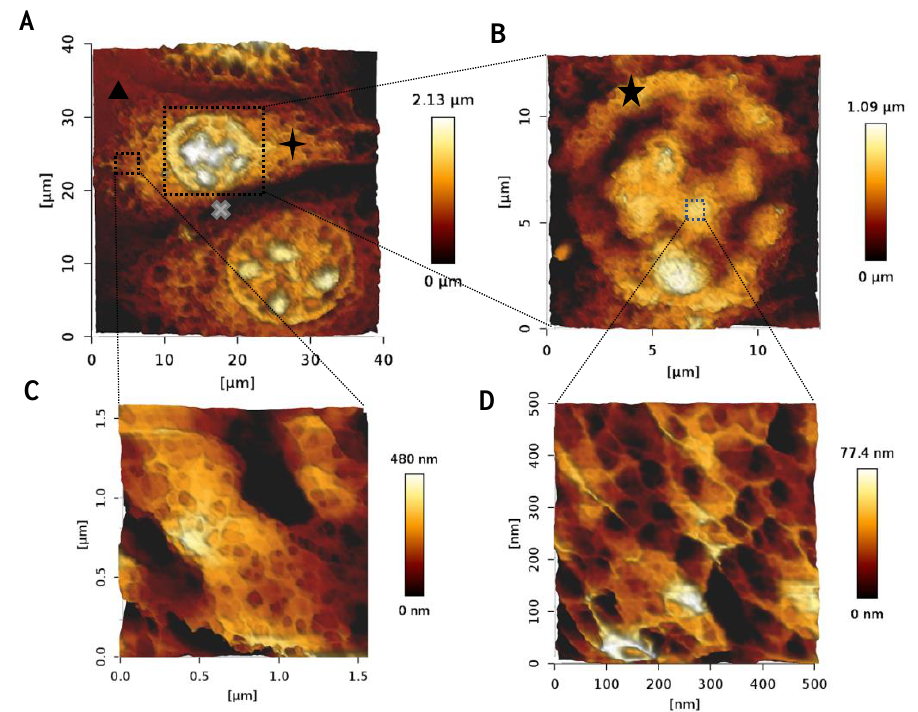
Figure 5. AFM 3D images taken in PBS of ( A ) a chondron isolated from SA – GEL – GA, ( ) TM, ( ) IM, and ( ) lacunae. ( B ) A chondrocyte showing the retained circular morphology and internal organelles, ( ) PCM. ( C ) A close-up on the nanostructure of the ECM surrounding chondrocytes within chondron, and ( D ) the nanostructure of a region on top of the chondrocyte. To further confirm this observation, the presence of a PCM, TM, and IM was investi-